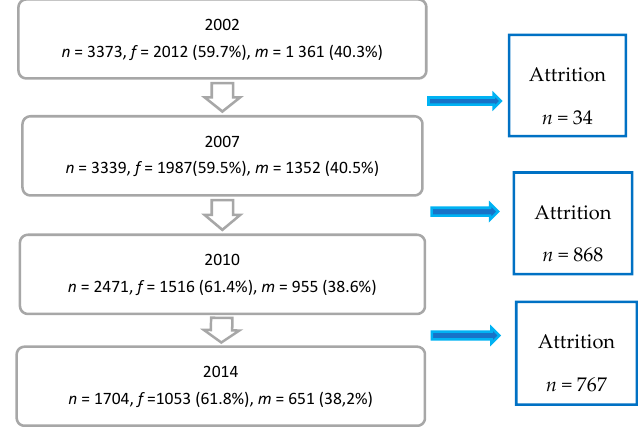
Figure 1. Flow-chart of respondents in the 18–29 age group of the Stockholm Public Health Cohort 2002, 2007, 2010, and 2014.